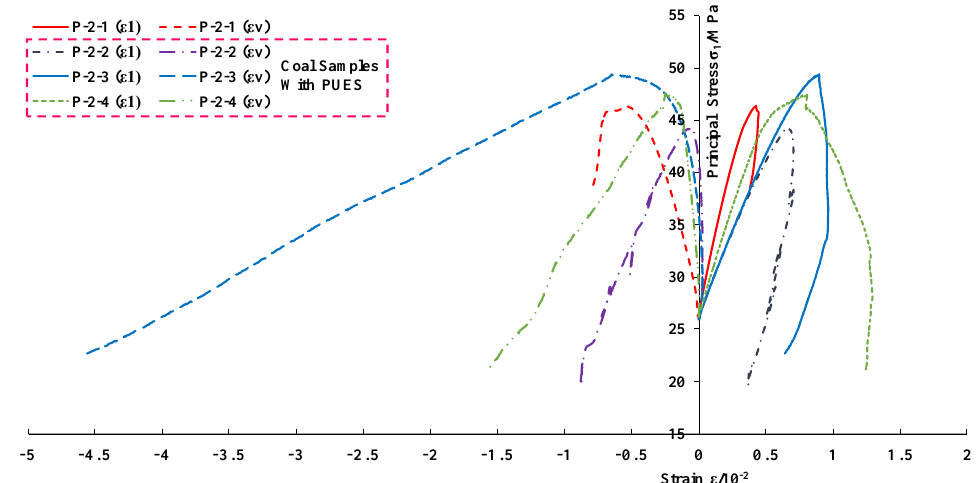
Figure 9. The mining-induced mechanical behavior of coal under PCM with a 2 MPa gas pressure difference.